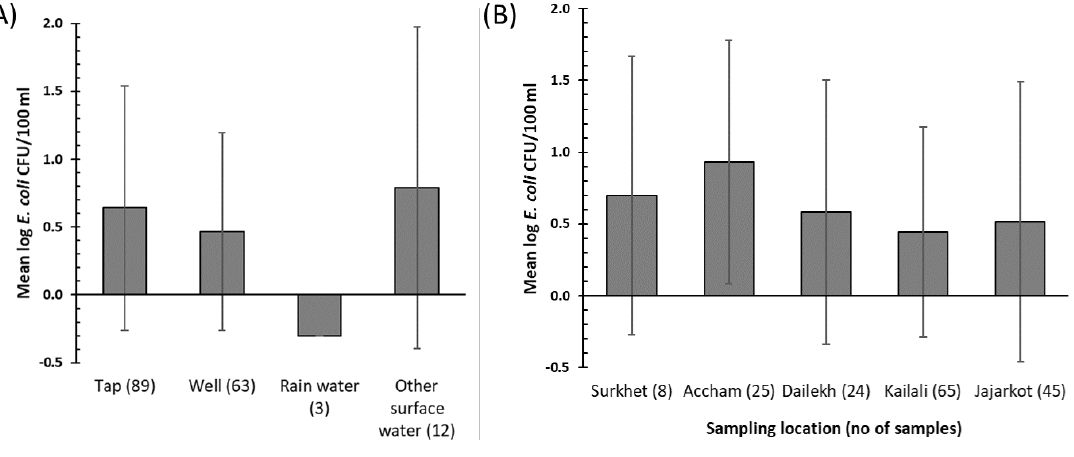
Figure 4. ( A ): Mean log 10 E. coli concentration detected in the different types of POC (standard deviation bars shown). ( B ): Mean log 10 E. coli concentration detected at the POC in each district. A measurement of zero E. coli was replaced by 0.5 to enable the log transformation.